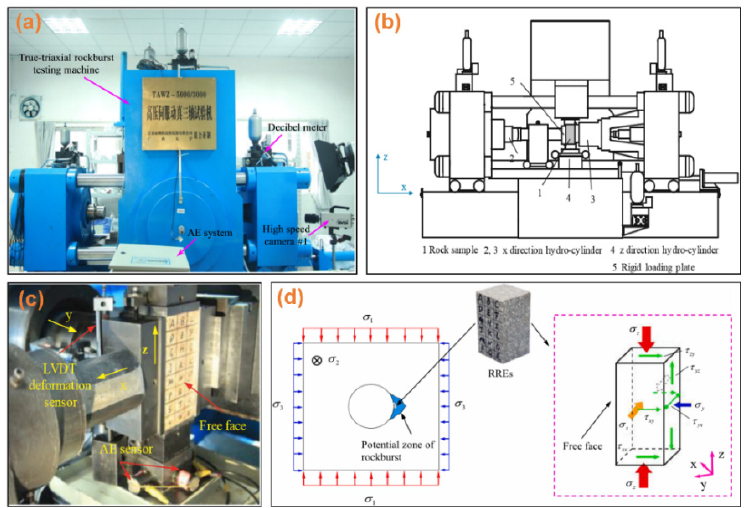
Figure 1. A true triaxial strainburst testing facility: ( a , b ) are the loading configuration; ( c ) is the stressed rock sample; ( d ) shows the boundary conditions and stress state of the rock sample (( a ) is from Su et al. [34]; ( b – d ) are from Hu et al.